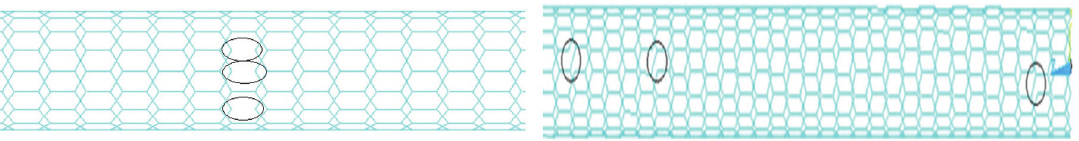
Figure 12. The locations of three broken covalent bonds in (9, 0) CNT leading to the highest reduction (left) and the lowest reduction (right) in CNT